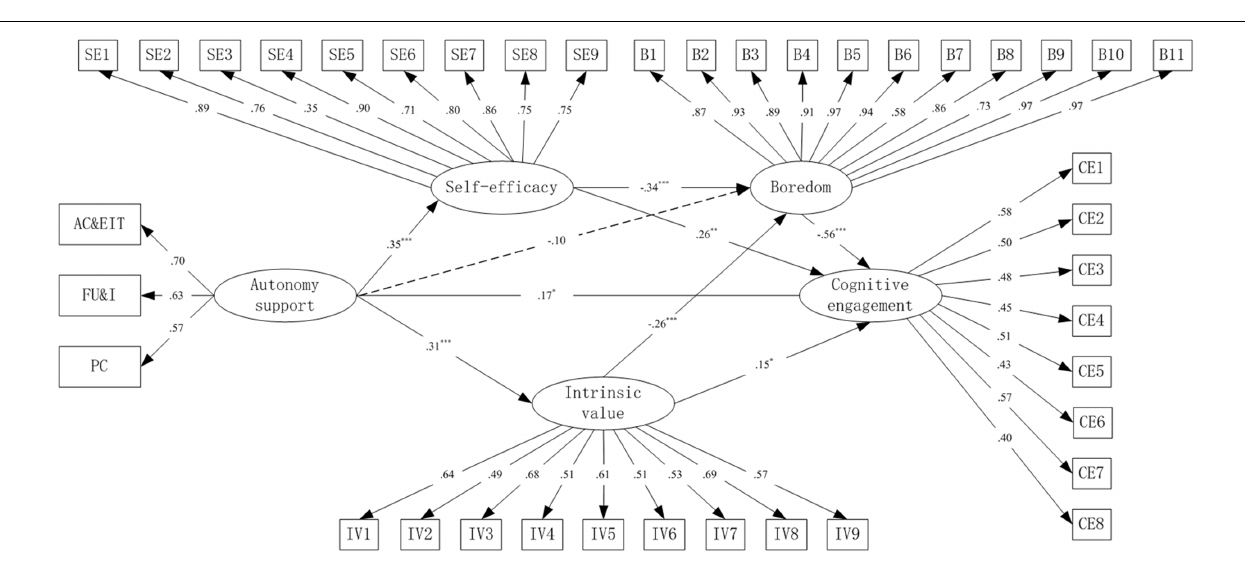
(self-efficacy: β = 0.16; intrinsic value: β = 0.13) and cognitive engagement (self-efficacy: β = 0.19; intrinsic value: β = 0.15). For emotional engagement, boredom partially mediated the effect of self-efficacy ( β = 0.26), while fully mediated the effect of intrinsic value ( β = 0.21). More important, the individual factors